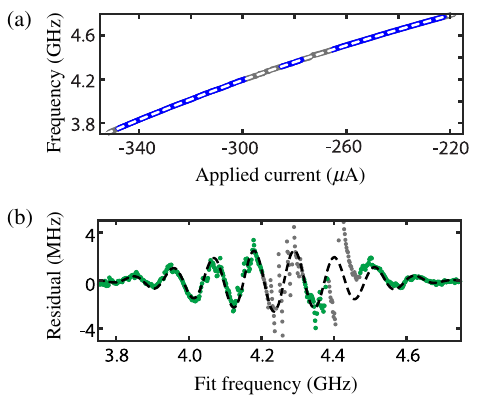
FIG. 6. Avoided crossings analysis. (a) The measured qubit- cavity avoided crossings are fit by a multimode interaction model (white) [Fig. 2]. (b) The spacings between the modes f δ are well matched by a mirror model with a single-element reflectivity of ¼ 3 . 5% r s